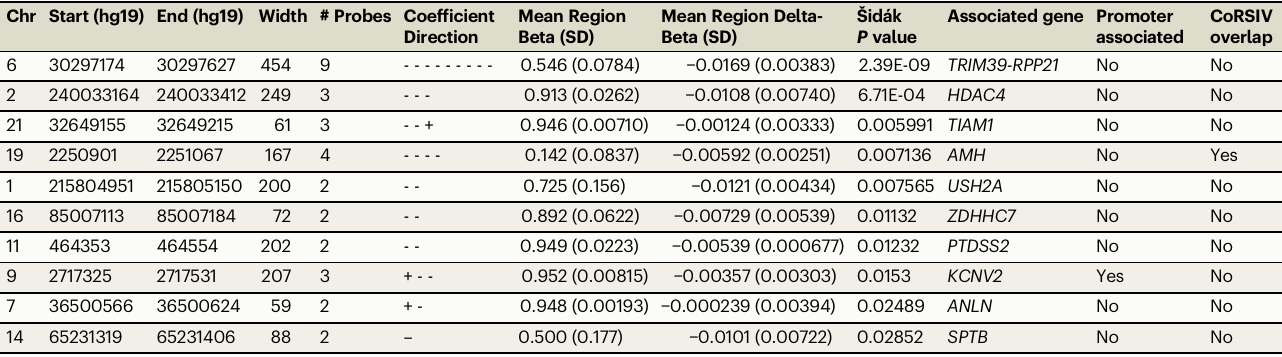
Table 3 | Differentially methylated